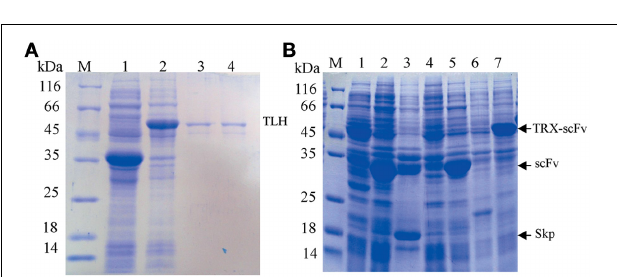
FIGURE 1 | Constructs of scFv with different fusion formats used in this study. MCS, Multiple cloning sites; Stop, stop codon; scFv, single chain variable fragment; Skp, molecular chaperone Skp; TRX, thioredoxin.